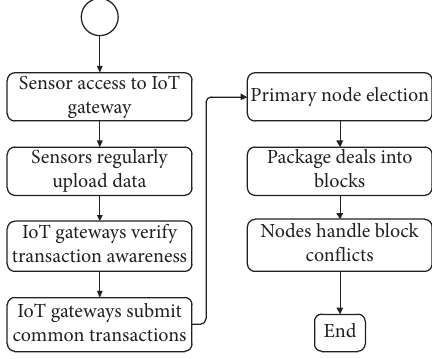
Figure 2: Algorithm